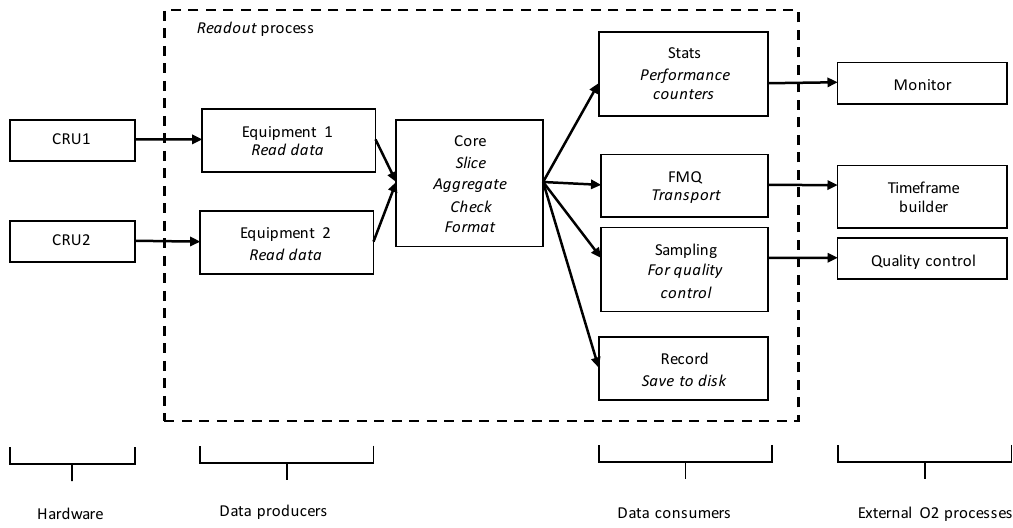
Fig. 1. Readout architecture and internal data flow (example runtime